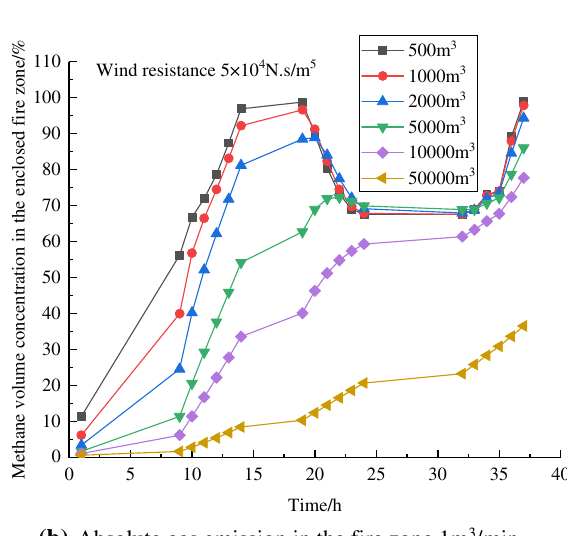
(a) Absolute gas emission in the fire zone 10m 3 /min